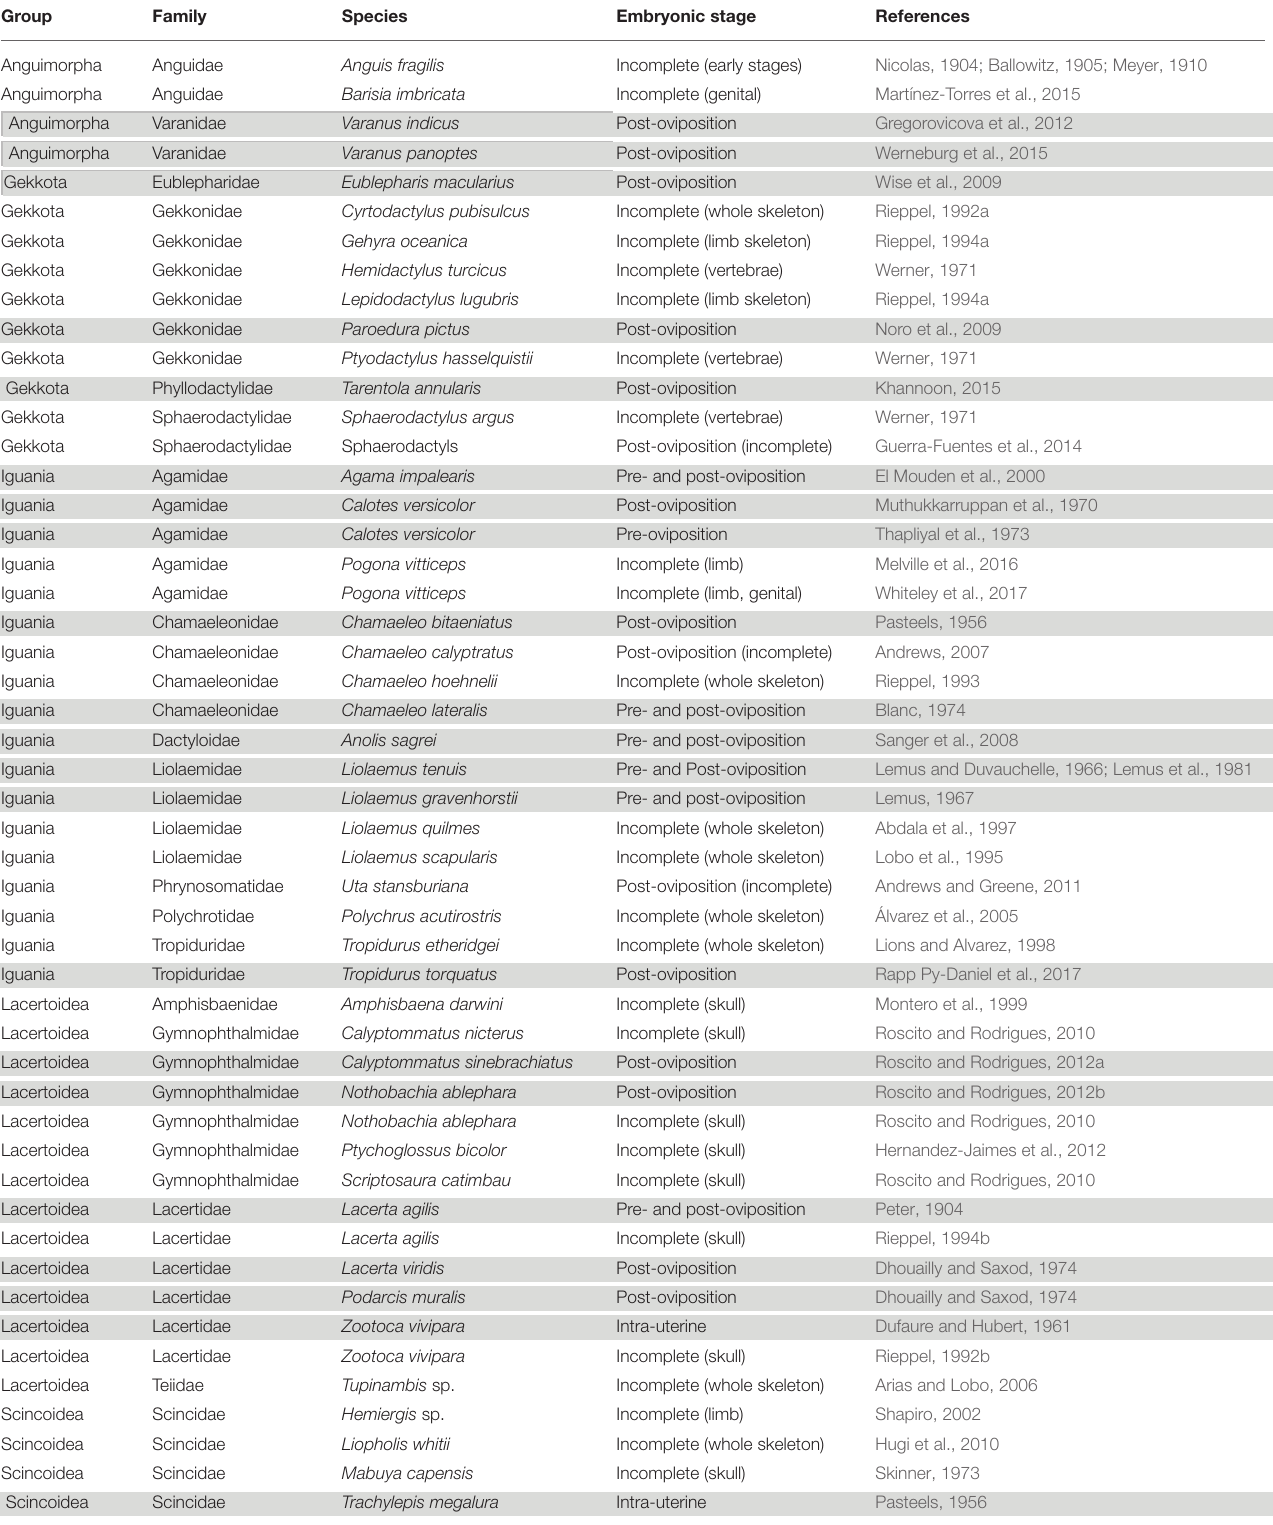
TABLE 1 | Summary of complete and incomplete embryonic staging data available for